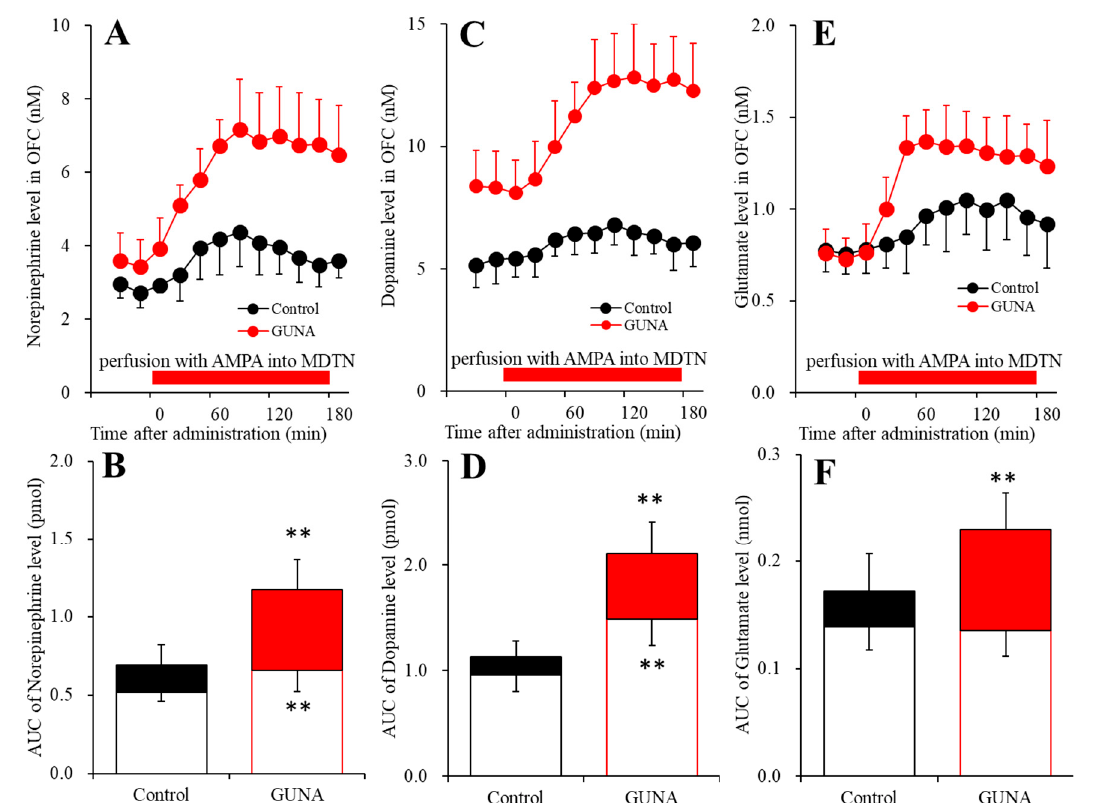
Figure 7. Effects of acutely local administration (perfusion with) 100 µ M α -amino-3-hydroxy-5-methyl-4-isoxazolepropionic acid (AMPA) into the MDTN on extracellular levels of norepinephrine, dopamine and L-glutamate in the OFC, after the systemically chronic administration of guanfacine (0 or 0.12 mg/kg/day for 14 days). Panels ( A , C , E ) indicate the effects of perfusion with 100 μ M AMPA into the MDTN after chronic administration of guanfacine (0 or 0.12 mg/kg/day) for 14 days on extracellular levels of norepinephrine, dopamine and L-glutamate in the OFC, respectively. Ordinates: mean ± SD (n = 6) of extracellular levels of norepinephrine (nM), dopamine (nM) or L-glutamate ( μ M), abscissa: time after administration of perfusion with AMPA into the MDTN (min). Red bars: perfusion of 100 μ M AMPA into the MDTN. Panels ( B , D , F ) indicate the AUC20–180 min values of extracellular levels of norepinephrine, dopamine and L-glutamate during perfusion with AMPA (from 20 to 180 min). Ordinates: mean ± SD (n = 6) of AUC20–180 min values of extracellular levels of norepinephrine (pmol), dopamine (pmol) and L-glutamate (nmol), respectively. Opened, black and red columns indicate AUC vales during pre-AMPA and AMPA-evoked releases control and chronic guanfacine administrations, respectively. When the effects of AMPA were statistically significant compared using MANOVA, the data were analysed using Tukey’s post hoc test. ** p < 0.01, compared with control.